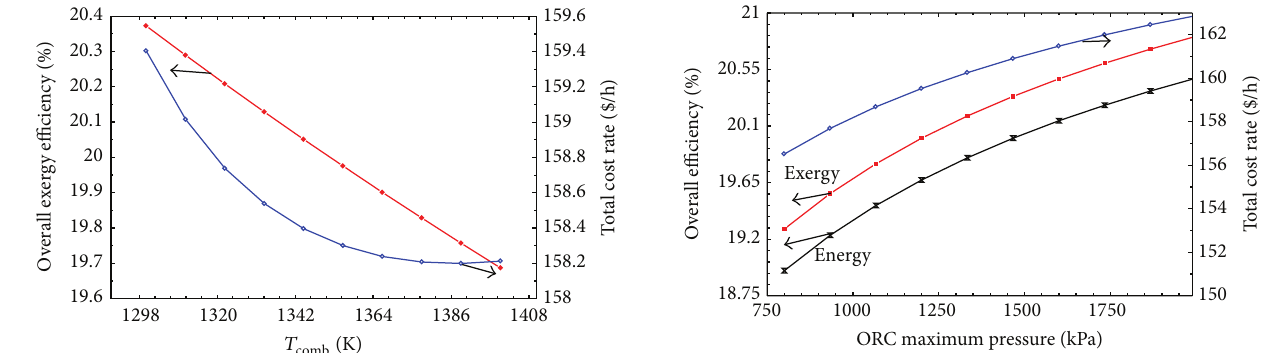
Figure 5: The impact of the combustion temperature on the two objective functions.